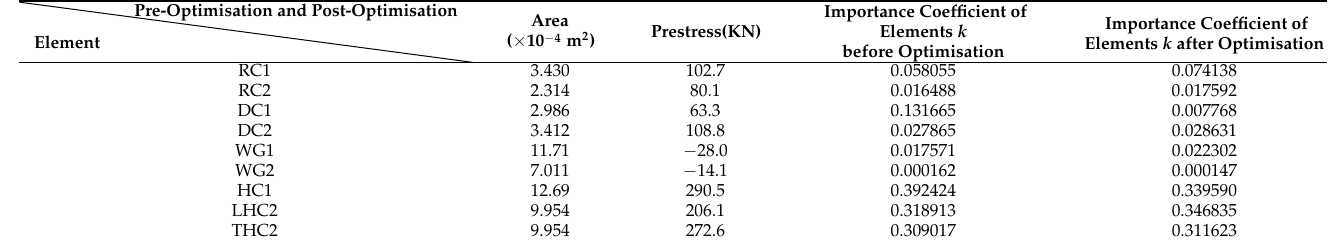
Table 6. Importance coefficients of the elements before and after cable arrangement optimisation.